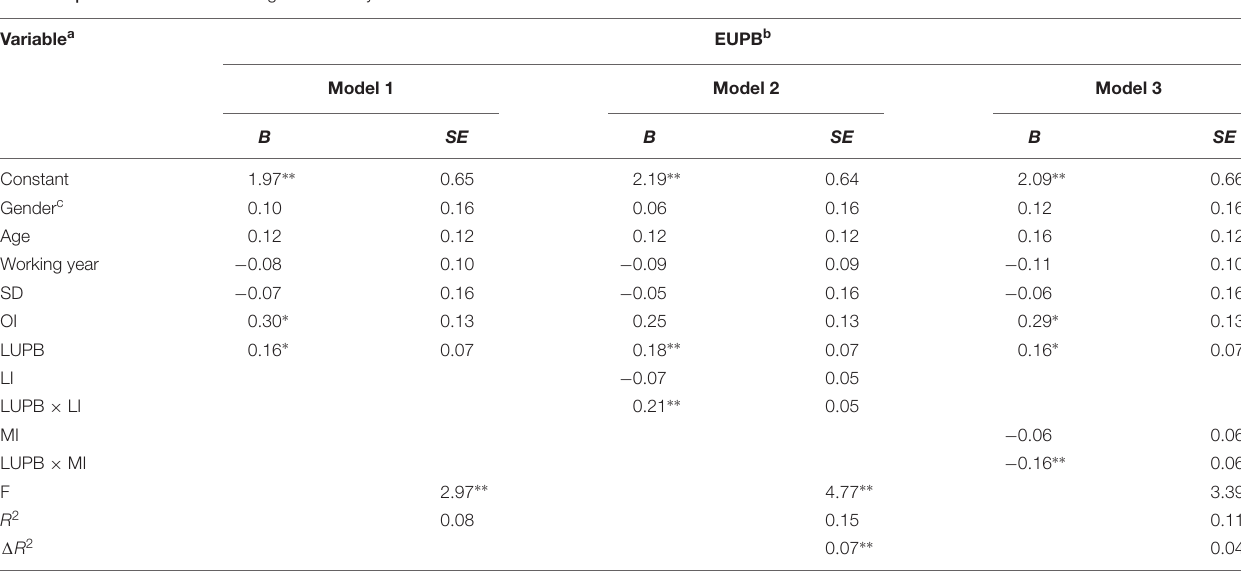
TABLE 3 | Results of hierarchical regression analyses with